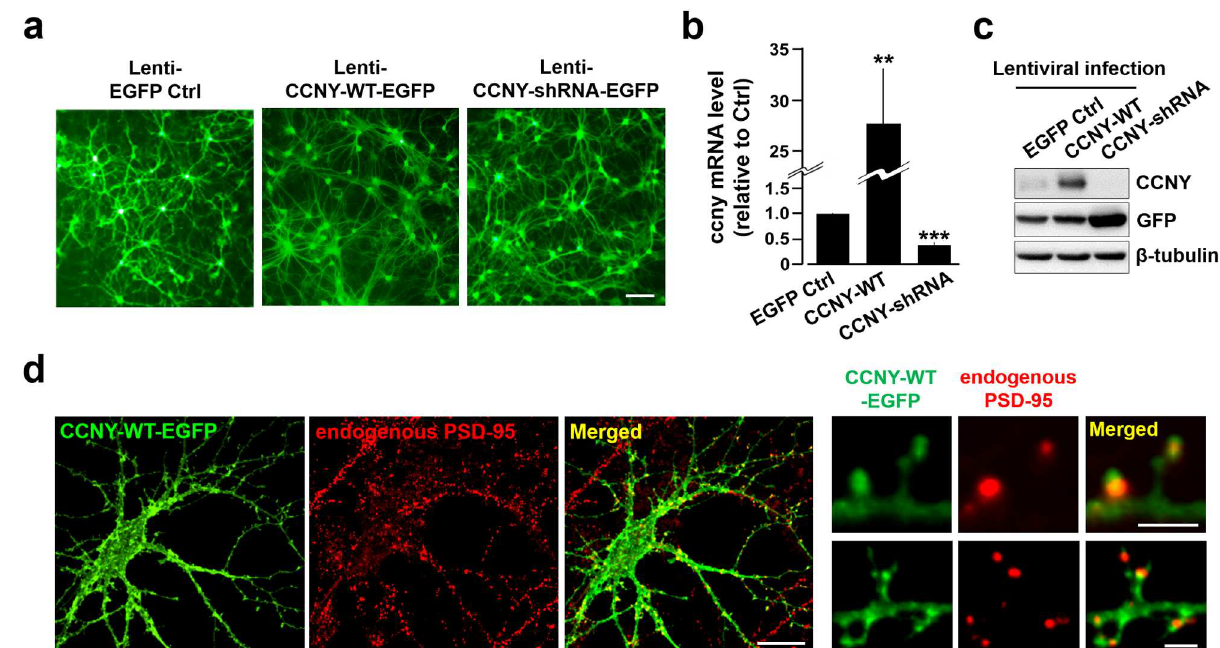
Fig 1. Experimental model systemsfor RNA-seq based transcriptome analysis. ( a ) Culturedhippocampal neuronsexpressingEGFP (Lenti-EGFP Ctrl), CCNY-WT-EGFP (Lenti-CCNY-WT-EGFP) or CCNY-shRNA-EGFP (Lenti-CCNY-shRNA-EGFP) via lentiviral expressionsystem. ( b , c ) Relativelevels of mRNA ( b ) and protein ( c ) of CCNY from the neuronsinfected with lentivirusexpressingEGFP, CCNY-WT-EGFP or CCNY-shRNA-EGFP. n = 5 from 3 independent experiments. ** p < 0.01relativeto control, *** p < 0.005relativeto control, student’s t test. Refer to the S9 Fig for the full-length blots of ( c ). ( d ) CCNY-WT exists in the spines near the endogenous PDS-95 in cultured hippocampal neurons,supportingthe value of the study on systematic analysisfor putative neuronalfunctions of CCNY. Scale bars, 20 and 2 μ m for the wholeneuronaland enlargedimages,